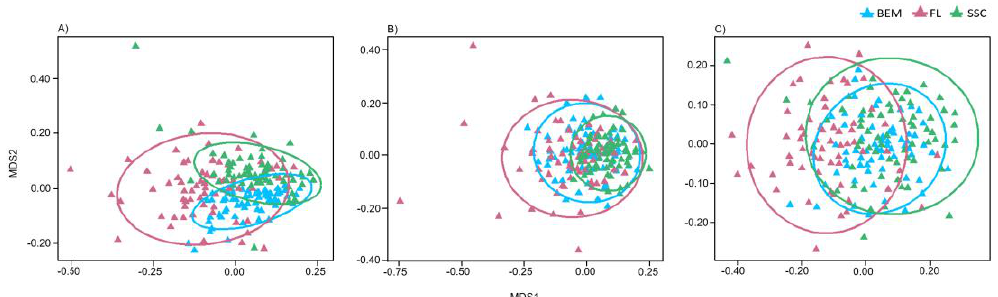
Figure 4. Non-metric multi-dimensional scaling, to model the effect of time on soil ( A ) overall fungal, ( B ) pathogen and ( C ) saprotroph community composition collected at different sampling points across all cultivars and replication blocks. BEM, before emergence; FL, flowering stage; SSC, senescence stage. Table 1. Effects of cultivar, sampling time, and cultivar × sampling time interaction on the richness of all fungi, saprotrophic fungi, and plant pathogenic fungi in soil and roots.